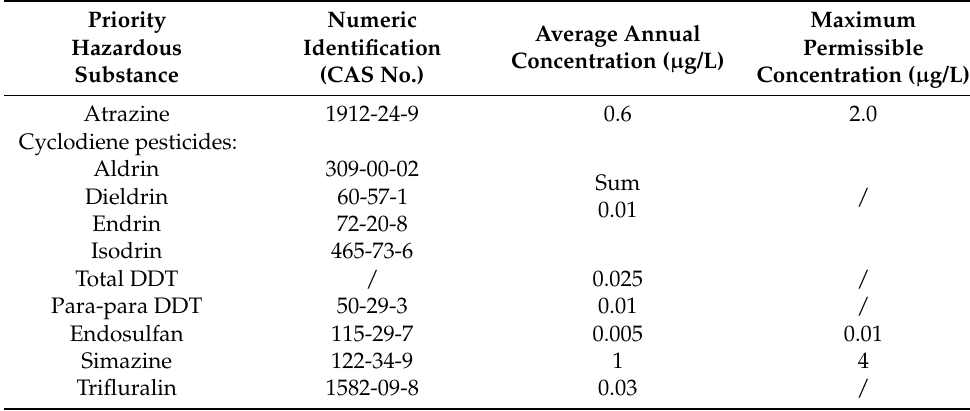
Table 10. Limit values for individual pesticides in surface water